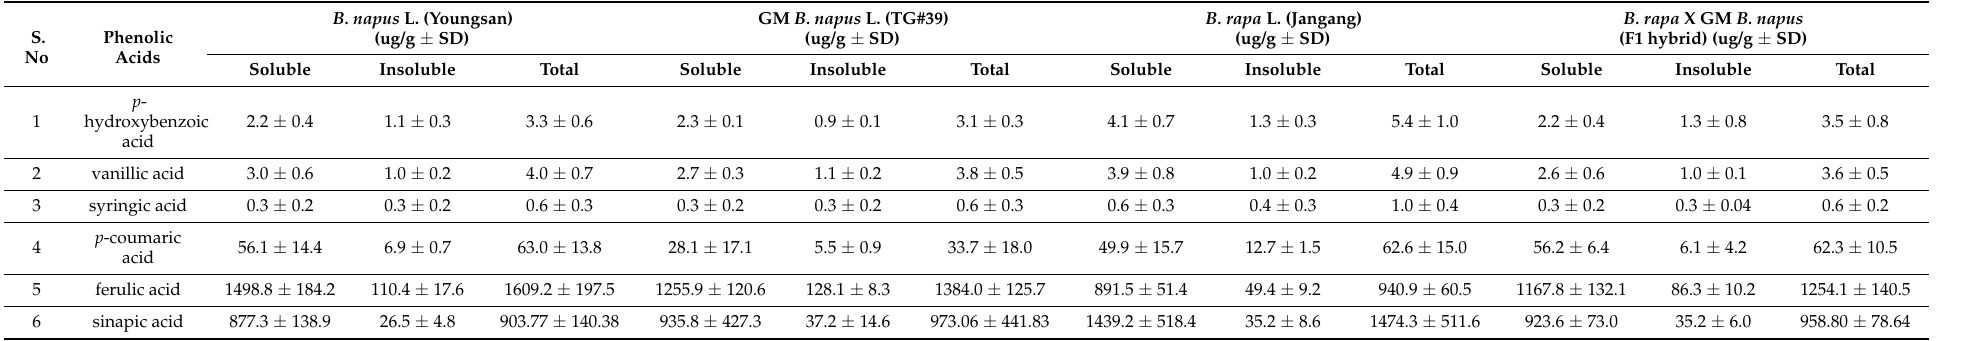
Table 5. Total phenolic acid composition analysis using